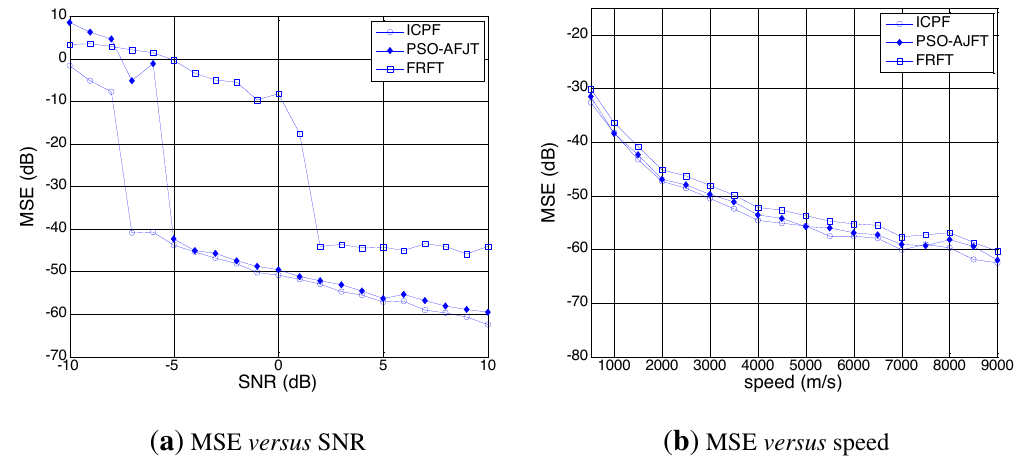
Figure 7. MSE for ICPF, particle swarm optimization-adaptive joint time-frequency (PSO-AJFT) and fractional Fourier transform